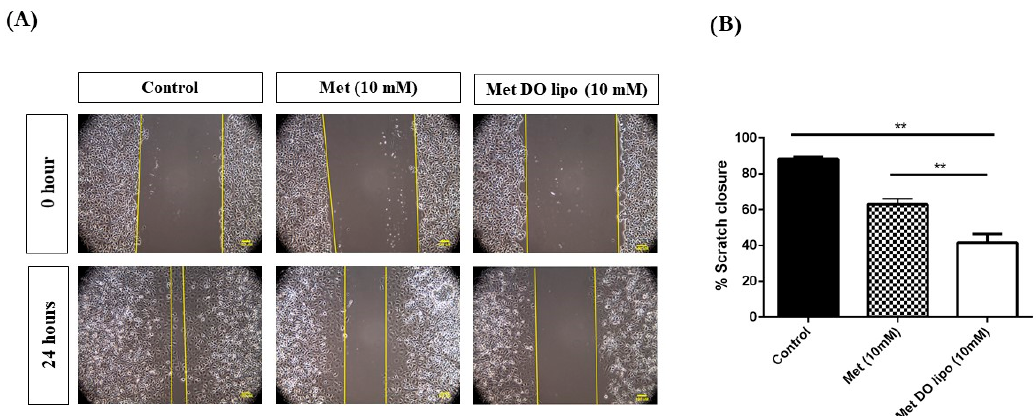
Figure 6. Effect of treatment on cell migration property of MDA-MB-231. ( A ) Microscopic images of scratch after different incubation periods with treatment: 0 h and 24 h. Scale bar = 100 μ m ( B ) Quantitative representation of treatment effect on cell migration of MDA-MB-231 cells treated with Met and Met DO lipo expressed as % scratch closure at various time intervals. Data represent mean ± SD ( n = 3). ** p < 0.01.